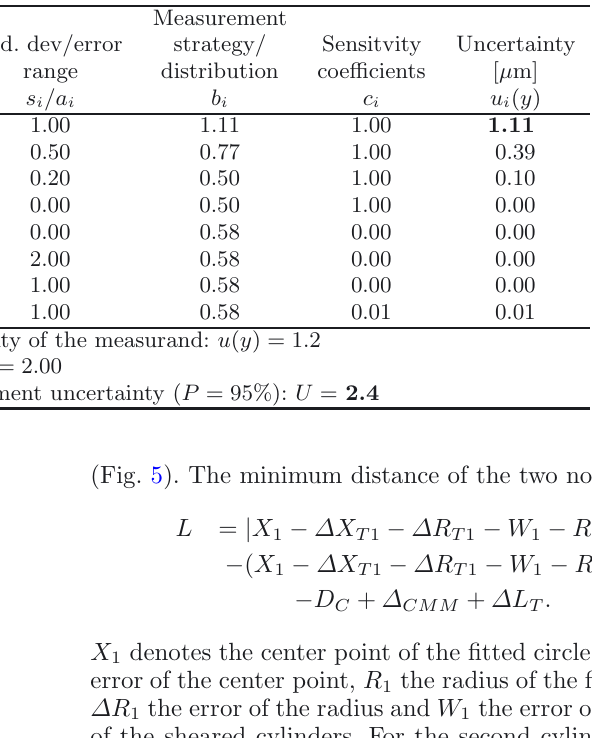
X 1 denotes the center point of the fitted circle,